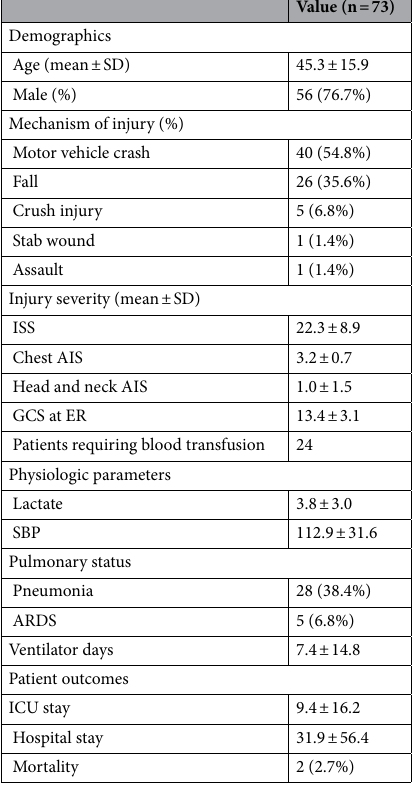
Table 1. Patient characteristics and in-hospital outcomes. ARDS acute respiratory disease syndrome, AIS abbreviated injury scale, ER emergency room, GCS Glasgow coma scale, ICU intensive care unit, ISS injury severity score, SBP systolic blood pressure, SD standard